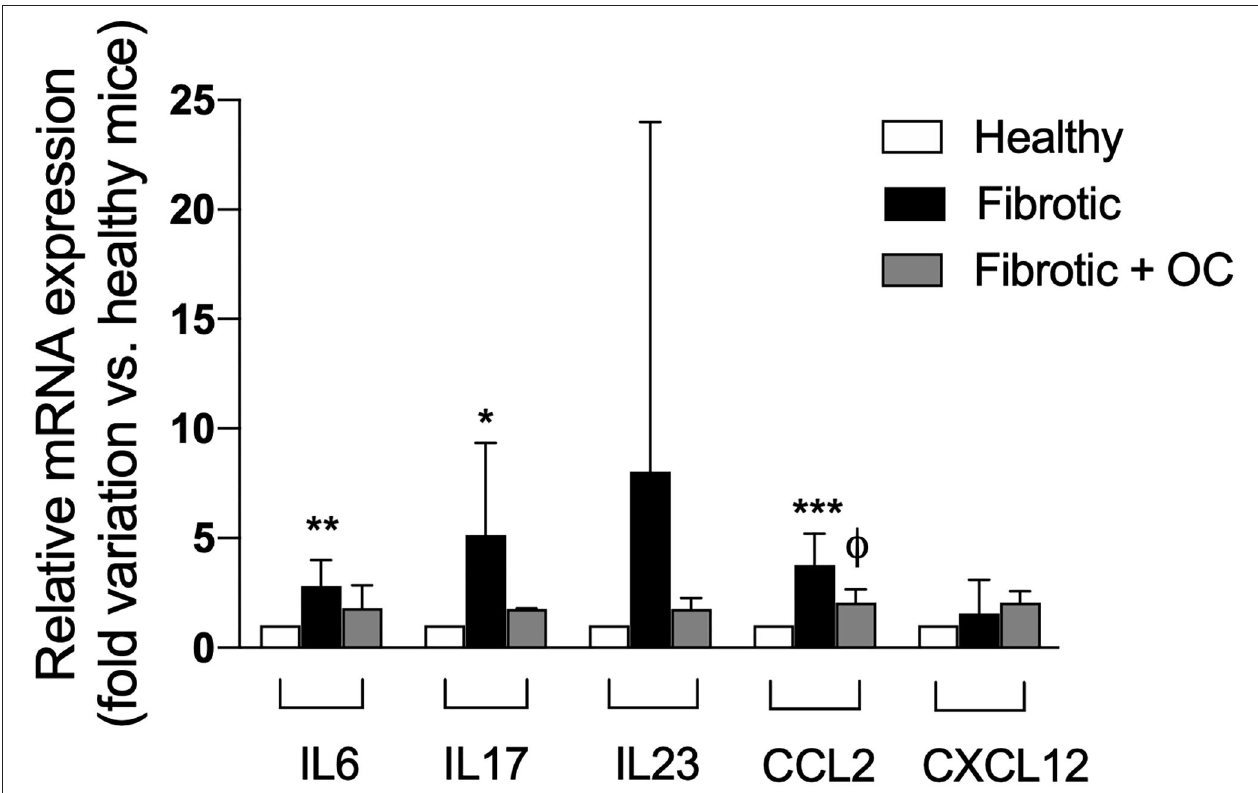
FIGURE 9 | Effect of OC on hepatic gene expression of inflammatory cytokines in a mouse model of fibrosis. * P < 0.05, ** P < 0.01 and *** P < 0.001 vs. control mice, φ P < 0.05 vs. fibrotic mice. Results are obtained by analyzing 6 animals per group in triplicate and have been analyzed by one-way ANOVA followed by the Tukey’s post hoc